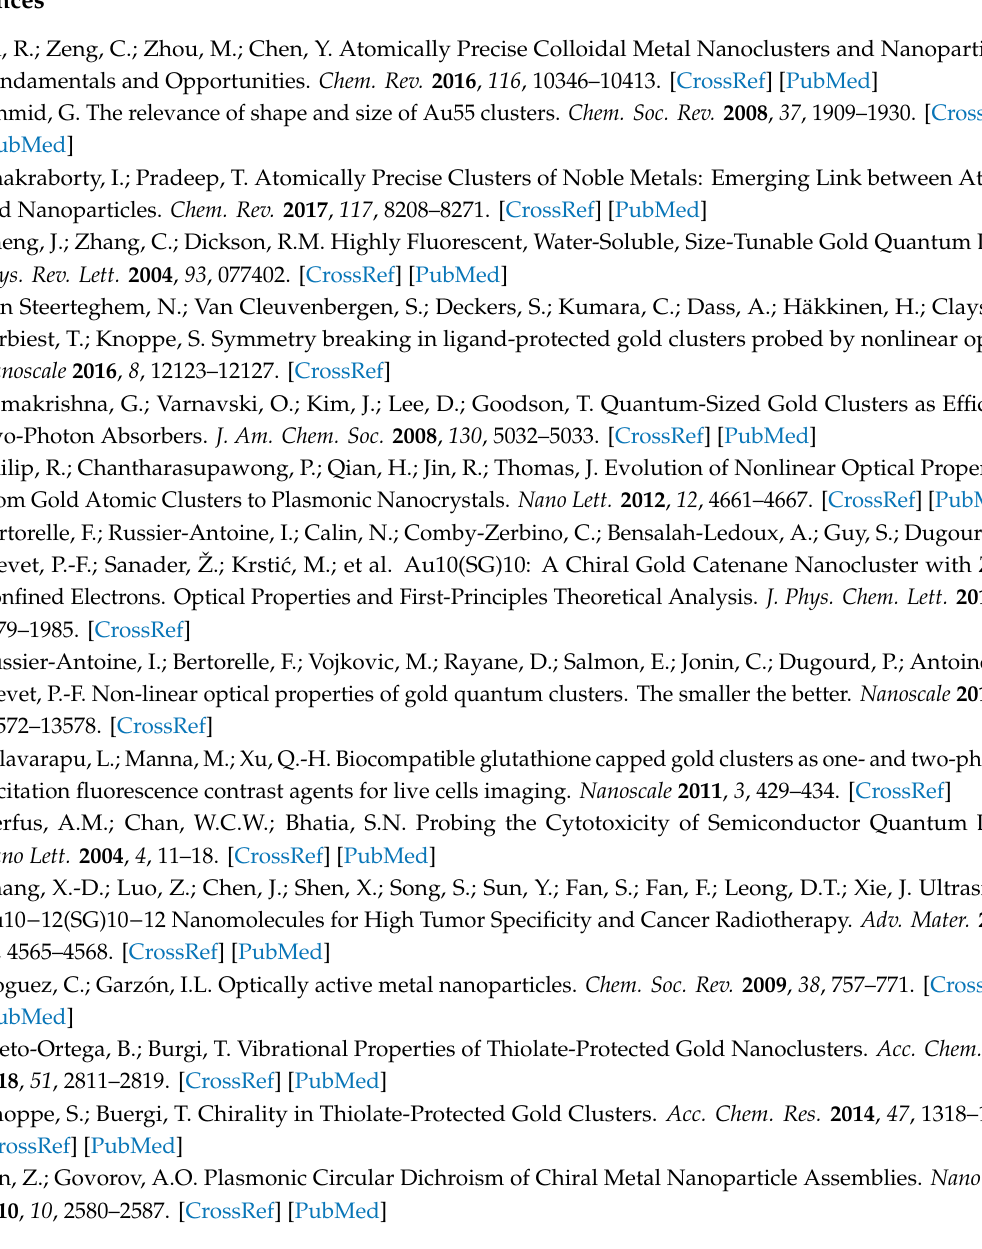
Figure S1: UV-vis spectra of Au 10 solution after addition of the positively charged H 2 TMPyP 4 + . Figure S2: Spectral changes of Au 10 clusters upon addition of HCl (pH 2) within 1 h. Figure S3: Photographs of gold plated cuvettes on dark and white backgrounds. Figure S4: UV-vis spectra of Au 10 solutions upon acidification. Figure S5: AuNPs prepared from histidine and NaBH 4 and of a glass dipped in the corresponding solutions at acidic pH. Figure S6: UV-vis and CD spectra of residual TPPS solution after formation of co-deposit. Figure S7: Circular dichroism (CD) spectra of co-deposit J-aggregates and AuNPs. Figure S8: Histograms of the height and diameter distributions, height profiles of Au nanostructures and TPPS J-aggregates deposited on glass surfaces. Figure S9. AFM image and relative